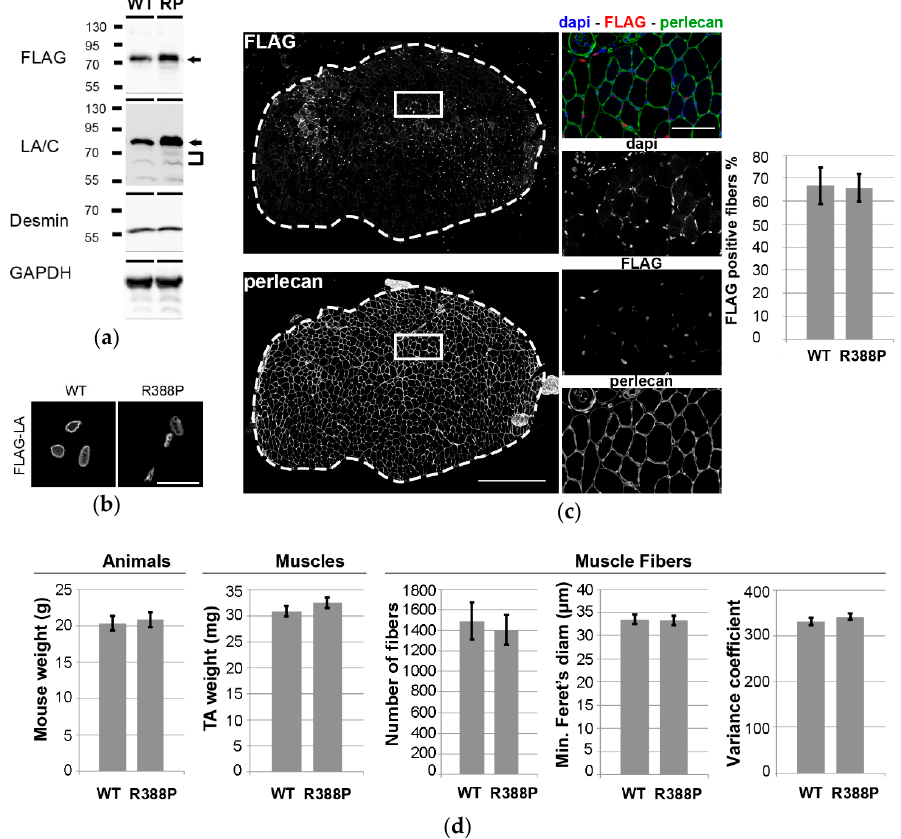
Figure 1. Impact of Adeno-associated virus (AAV)-mediated lamin A (LA) expression on phenotypes of mouse Tibialis anterior (TA) muscles. ( a ) Western blot analysis of whole protein extracts of TA transduced with AAV-LA wild-type (WT) or mutant R388P (RP) tagged with FLAG. Ectopic lamin A (arrows) was detected using either anti-FLAG or anti-lamin A/C antibodies. Endogenous lamin A/C (brackets) was detected using anti-lamin A/C antibodies. Desmin and GAPDH were used as loading controls. ( b ) In situ detection of ectopic lamin A using anti-FLAG antibodies on transverse sections of TA expressing WT or mutant lamin A. Scale bar represents 20 μ m. ( c ) Representative images show in situ detection of ectopic lamins, perlecan, and DNA, in a TA muscle section upon expression of WT lamin A. Scale bar represents 500 μ m. Areas indicated by white squares are magnified in right panels, where scale bar represents 100 μ m. Graph shows the mean percentage of FLAG-positive areas detected on transverse sections ( n = 8–9). ( d ) Quantification of mouse body weight, TA muscle weight, mean number of fibers, mean minimal Feret’s diameter, and mean variance coefficient of myofiber diameter in transverse TA muscle sections upon expression of WT or mutant lamin A ( n = 10–11). Mice expressing WT or mutant lamin A had similar body weights (20 ± 0.5 g and 21 ± 0.5 g, respectively) and TA muscle weights (31 ± 1 mg and 33 ± 1 mg, respectively). To determine more specifically the characteristics of TA expressing WT or mutant lamin A, muscle sections were stained for FLAG and perlecan as above. Sections of muscles expressing WT or mutant lamin A had similar number of fibers (1490 ± 180 and 1405 ± 146, respectively), fiber diameters (34 ± 1 μ m and 33 ± 1 μ m, respectively), and variance coefficients of fiber diameter (331 and 342, respectively) (Figure 1d). Eventual defects in TA-transduced muscles were assessed through areas of inflammation or regeneration as indicated by central position of nuclei within fibers. In muscles expressing WT or